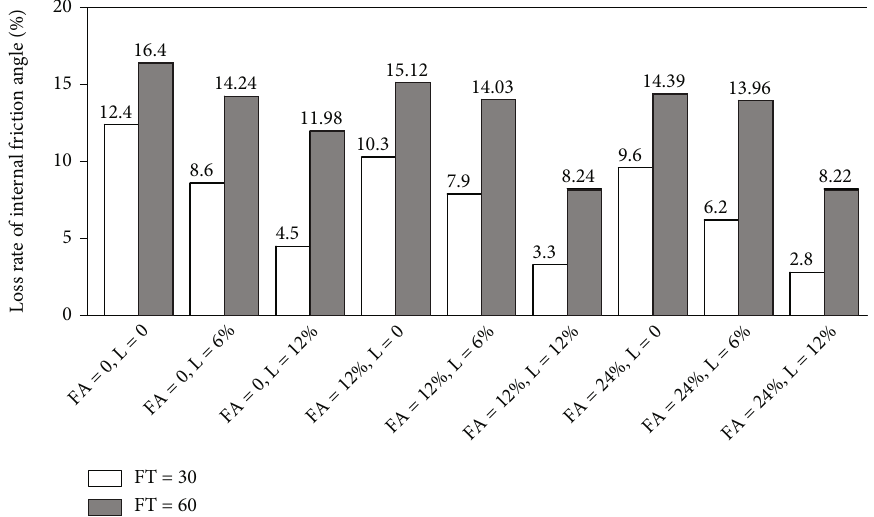
Figure 30: Loss rate of internal friction angle after freeze-thaw